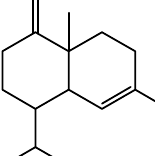
Figure 2. The semi-quantitative distribution of the main classes of organic volatiles in Pimpinella lutea growing in three different environmental conditions (North and South Bizerta and Tabarka) of Tunisia.